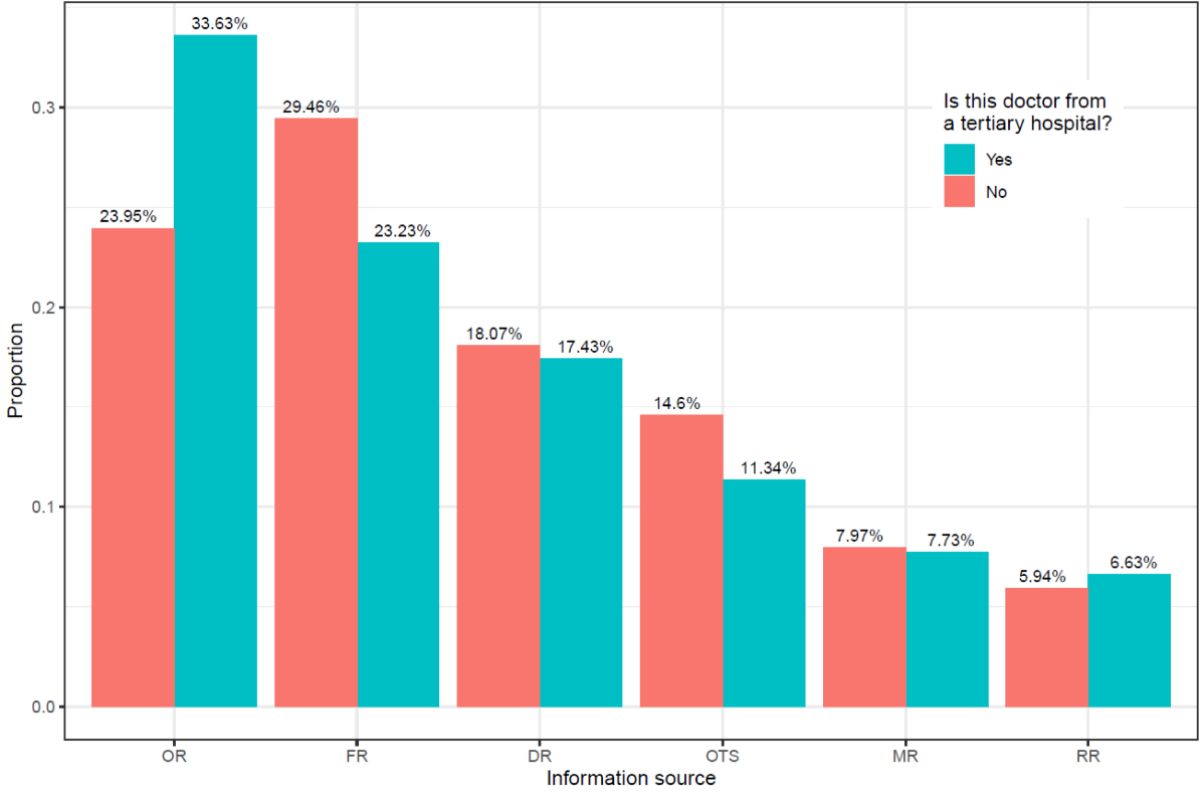
Figure 6. The influence of hospital on reasons for choosing doctors. DR: doctor recommendations; FR: family and friend recommendations; MR: multiple reasons; OR: online reviews; OTS: others; RR: random